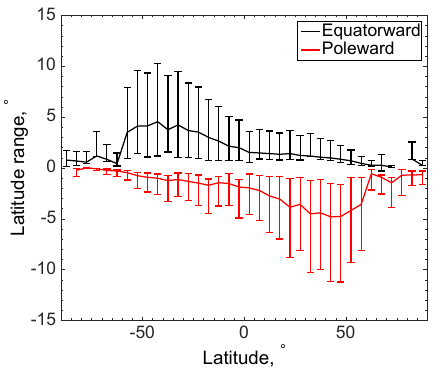
Figure 5. Average latitude ranges covered by ACE-FTS occulta- tions in a given 5 ◦ latitude bin, separated by an equatorward bias (black) and a poleward bias (red) as defined in the text. The error bars indicate 1 standard deviation from the mean latitudinal extent for the given 5 ◦ latitude